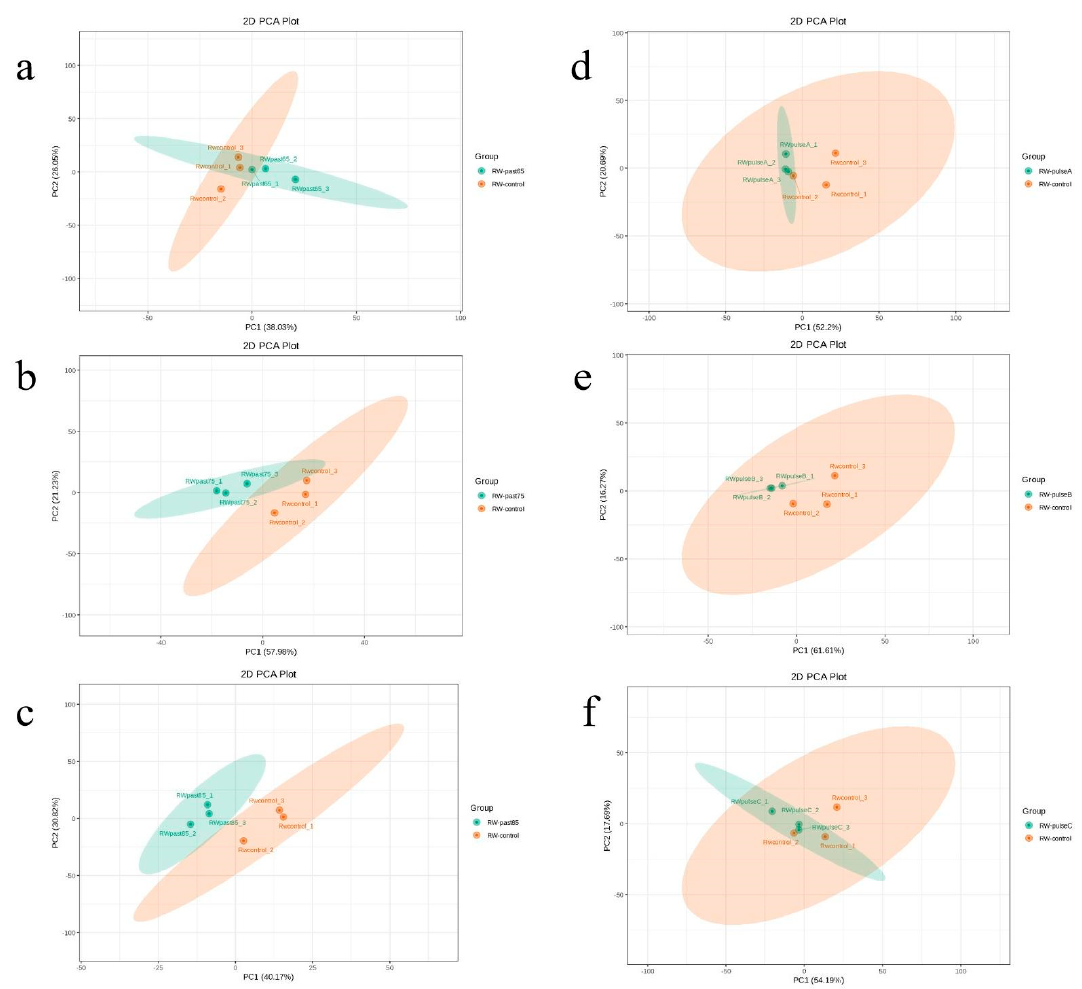
Figure 4. Principal component analysis (PCA) of flavor metabolites in SRW before and after sterili- zation. ( a ) Rw-control vs. Rw-past65. ( b ) Rw-control vs. Rw-past75. ( c ) Rw-control vs. Rw-past85. ( d ) Rw-control vs. Rw-pulse A. ( e ) Rw-control vs. Rw-pulse B. ( f ) Rw-control vs. Rw-pulse C.